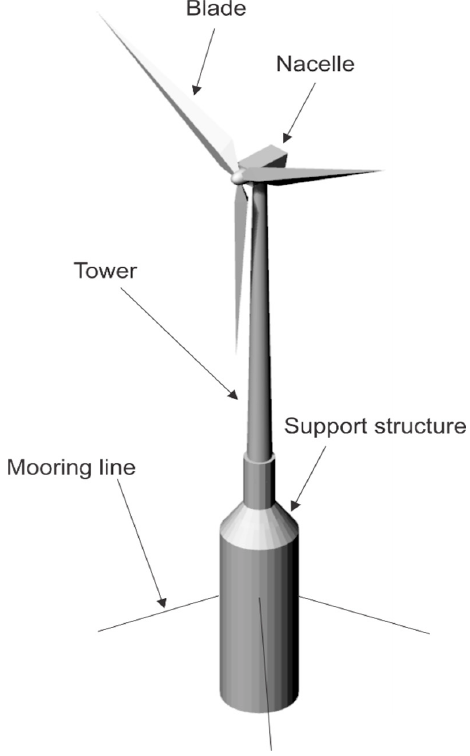
Figure 14. Floating Offshore Wind Turbine (FOWT) with a spar buoy support structure.